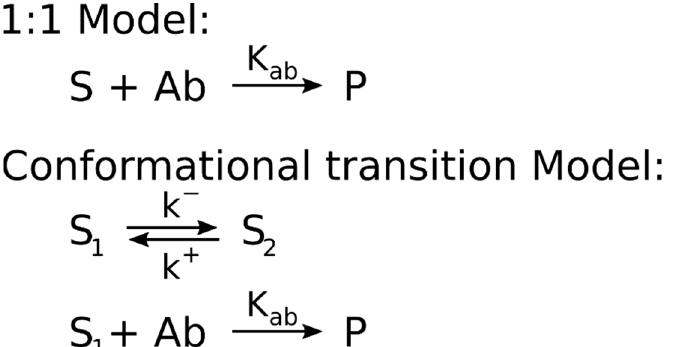
Figure 3. Binding kinetics between P4A1 antibody and WT or OM variants of RBD. ( A ) Binding kinetics for WT (blue) and OM (orange) RBD variants. In WT, the start of the binding phase is marked with black arrows, and the start of the dissociation phase is marked with gray arrows. Each sequential binding phase is conducted with a higher concentration of P4A1 (concentration is indicated above the corresponding arrow, x stands for 5 nm). For the OM variant, the same five-stage kinetics measurement was performed, and the start of each phase is obvious. ( B ) The binding phases are normed by the signal at the beginning. Colored curves correspond to the experimental signal, and dashed black lines represent the result of fitting with the Conformational Transition Model.